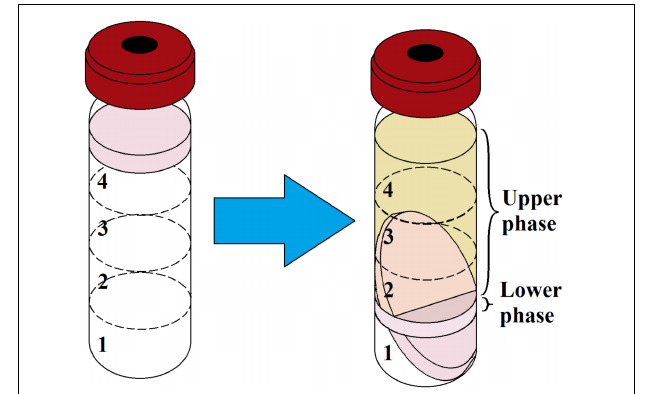
FIGURE 1 | Ultracentrifugation of prepared C. acnes RT5 biofilm biomass and matrix extraction. (Left) Gradient formation and inoculation of the sonicated biomass. (Right) Typical aspect of the two phases of the matrix after ultracentrifugation. Nos. 1, 2, 3, and 4 refer to the CsCl solutions as indicated in Table 1